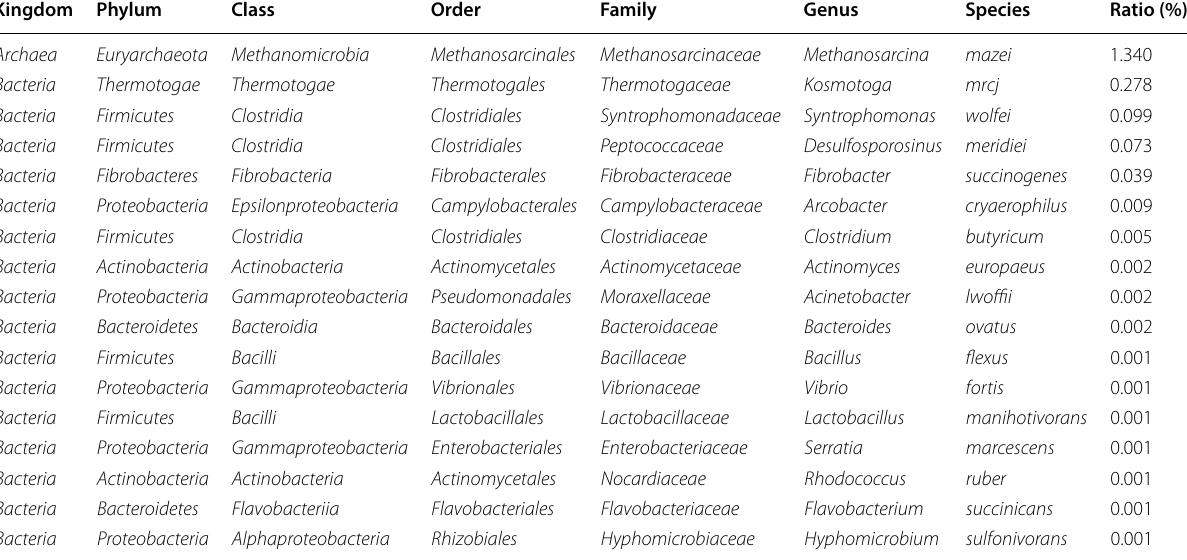
Table 2 Identification of 17 classes and their species by 16S rRNA sequencing Kingdom Phylum